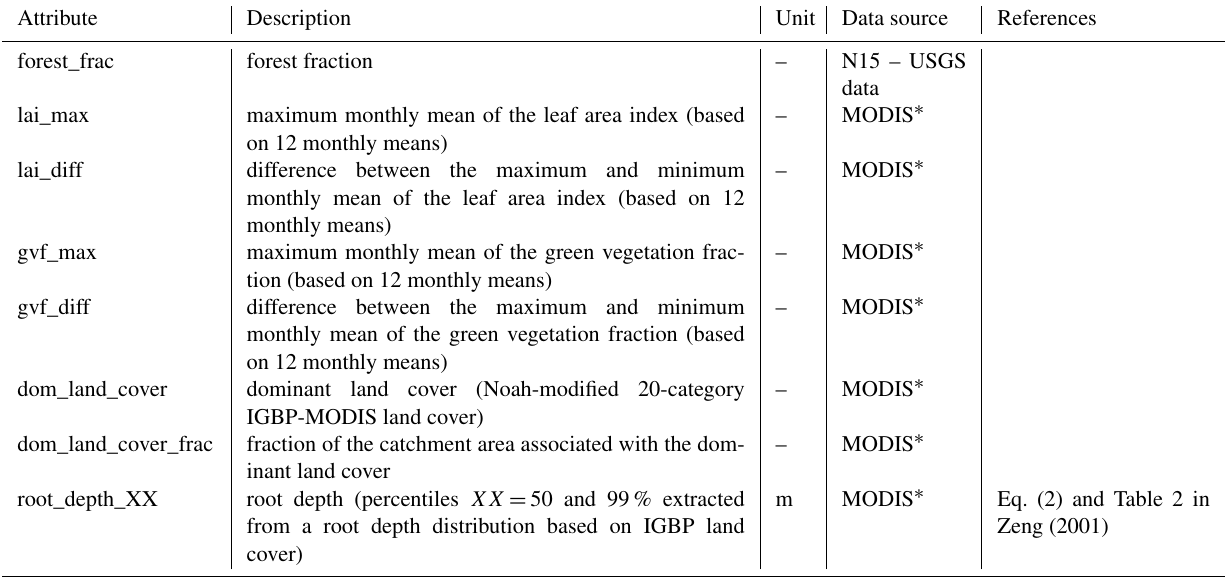
Table 4. Land cover